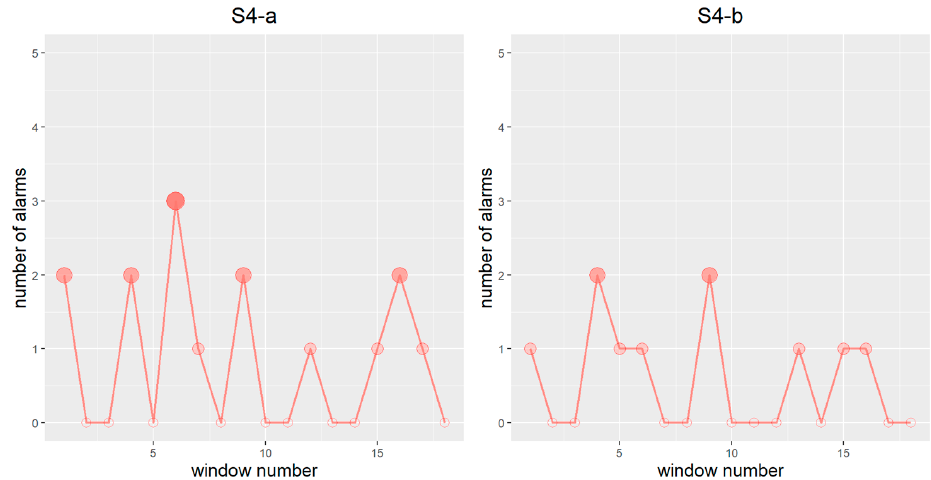
Figure 7. Sequence of the number of alarms obtained per 10 min by the random forest classifier (left/right for the abnormal/normal case).